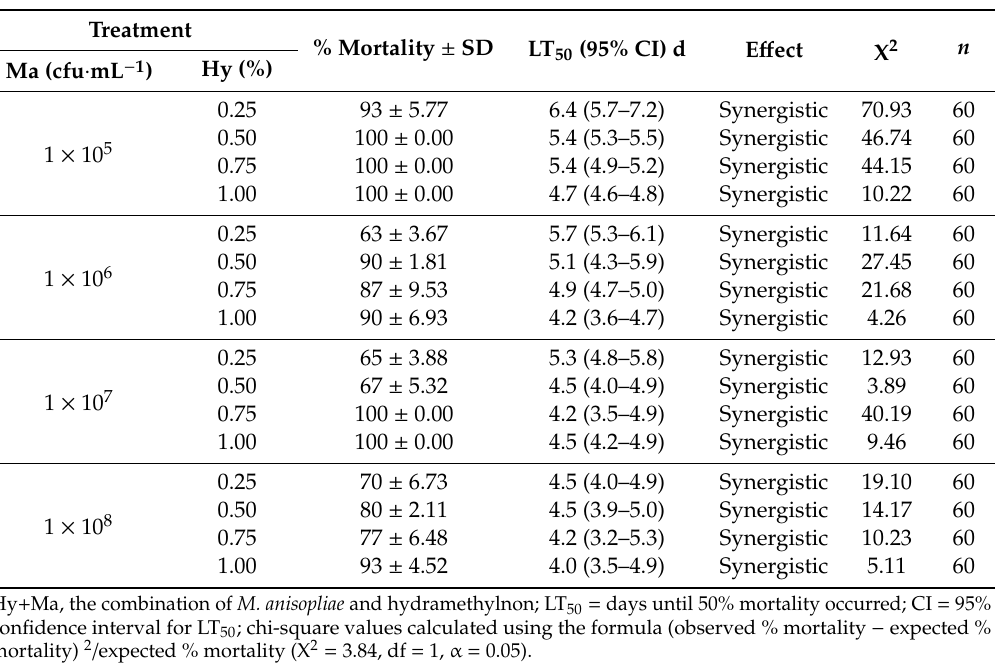
Table 2. Bioassays assessing the interactive e ff ects of combination treatments of M. anisopliae and hydramethylnon on adult male German cockroaches.